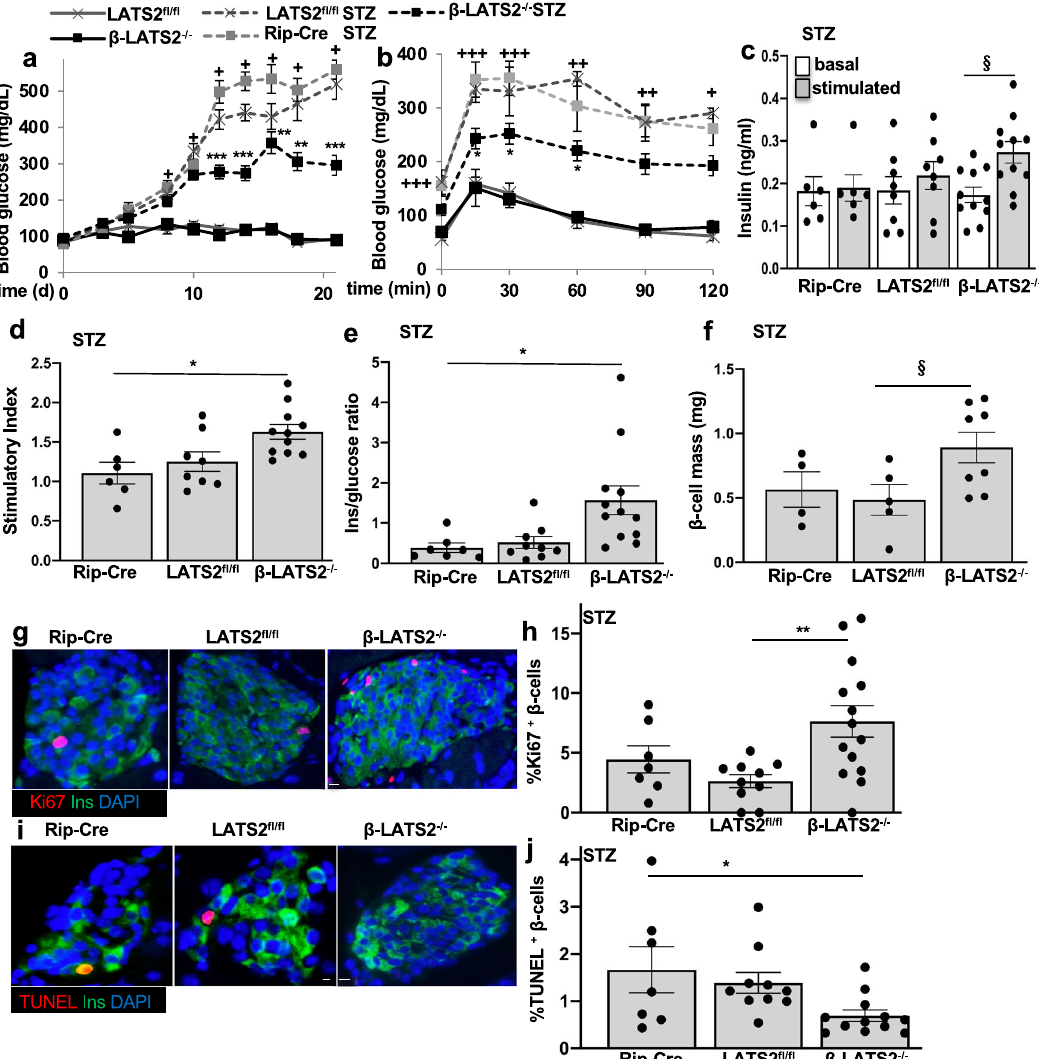
Fig. 5 β -cell speci fi c LATS2 ablation protects from STZ induced diabetes in vivo. a – j β -LATS2 − / − mice ( n = 14), RIP-Cre ( n = 7) and LATS2 fl / fl controls ( n = 10) injected with streptozotocin (STZ) (40 mg per kg body weight for 5 consecutive days) or saline ( β -LATS2 − / − n = 4; LATS2 fl / fl n = 5) for 5 consecutive days. a Random fed blood glucose measurements after fi rst saline or STZ injection (day 0) over 21 days and b i.p. glucose tolerance test (GTT) at day 19 in β -LATS2 − / − , Rip-Cre and LATS2 fl / fl mice. c Insulin secretion during an i.p.GTT measured before (0 min) and 15 min after glucose injection and expressed d as ratio of secreted insulin at 15 min to that secreted at 0 min (stimulatory index) (Rip-Cre STZ n = 6; LATS2 fl / fl STZ n = 8; β -LATS2 − / − STZ n = 11). e Ratio of secreted insulin and glucose calculated at fed state (Rip-Cre STZ n = 7; LATS2 fl / fl STZ n = 9; β -LATS2 − / − STZ n = 12). f – j Mice were sacri fi ced at day 22. f β -cell mass (given as percentage of the whole pancreatic section from 10 sections spanning the width of the pancreas) (Rip-Cre STZ n = 4; LATS2 fl / fl STZ n = 5; β -LATS2 − / − STZ n = 8). Representative images and quantitative analyses from triple staining for Ki67 ( g , h ) or TUNEL ( i , j ), insulin and DAPI expressed as percentage of TUNEL- or Ki67-positive β -cells ±SEM (Ki67: Rip-Cre STZ n = 7; LATS2 fl / fl STZ n = 10; β -LATS2 − / − STZ n = 14; TUNEL: Rip-Cre STZ n = 7; LATS2 fl / fl STZ n = 10; β -LATS2 − / − STZ n = 12). Data are expressed as means ± SEM. + p < 0.001 LATS2 fl / fl -STZ or RIP-Cre- STZ to LATS2 fl / fl control mice. ++ p < 0.01 LATS2 fl / fl -STZ or RIP-Cre-STZ to LATS2 fl / fl control mice. +++ p < 0.05 LATS2 fl / fl -STZ or RIP-Cre-STZ to LATS2 fl / fl control mice. * p < 0.05 β -LATS2 − / − -STZ to LATS2 fl / fl -STZ or RIP-Cre-STZ. ** p < 0.01 β -LATS2 − / − -STZ to LATS2 fl / fl -STZ or RIP-Cre-STZ. *** p < 0.001 β -LATS2 − / − -STZ to LATS2 fl / fl -STZ or RIP-Cre-STZ. § p < 0.05. One-way ANOVA with Tukey ’ s post hoc test for ( a , b , d , e , h , j ); by two-tailed Student ’ s t- tests for ( c , f ). scale bar depicts 10 μ